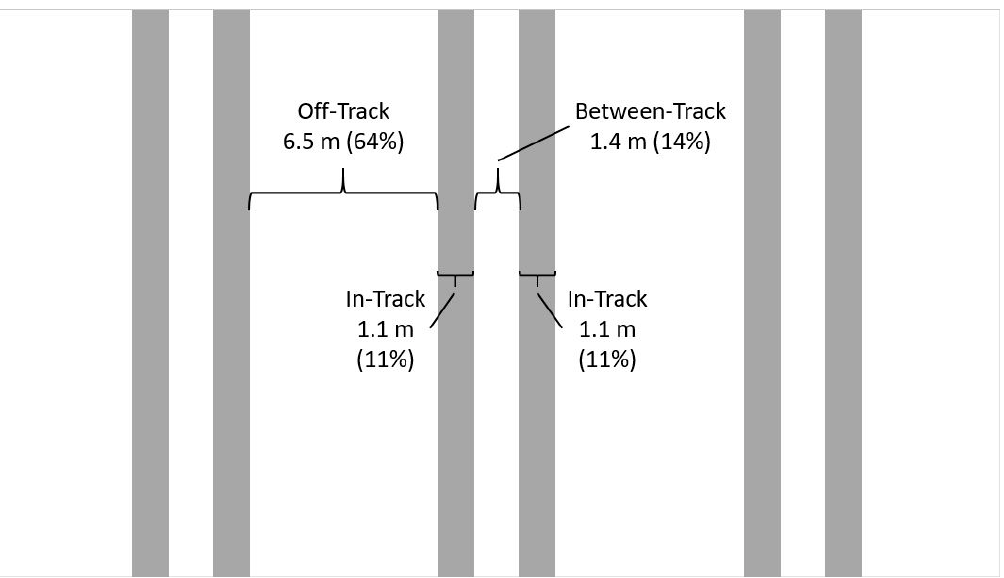
Figure 6. Average off-track, in-track, and between-track widths and the percentage of the total area each constitutes. These percentages were used to calculate the predicted weighted average erosion rates in order to derive an erosion rate representative of the entire area.